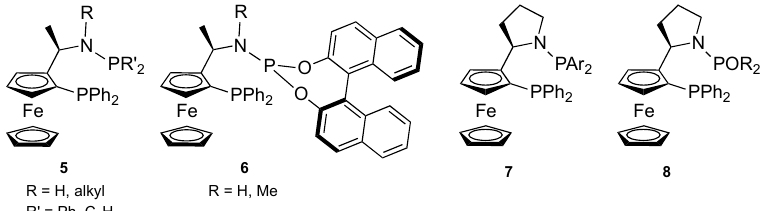
Figure 3. Ferrocenylphosphine-aminophosphine and ferrocenyphosphine-phosphoramidite ligands.